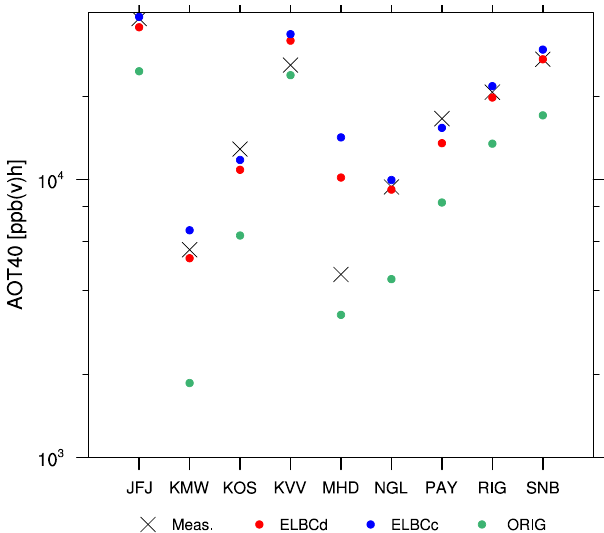
Figure 12. The AOT40 in ppb(v)h for the different in-domain ground-based measurements stations and the different LBC set- ups. The AOT40 is derived for a corresponding growing season in 2011, representing the months of April to September and at 07:00–